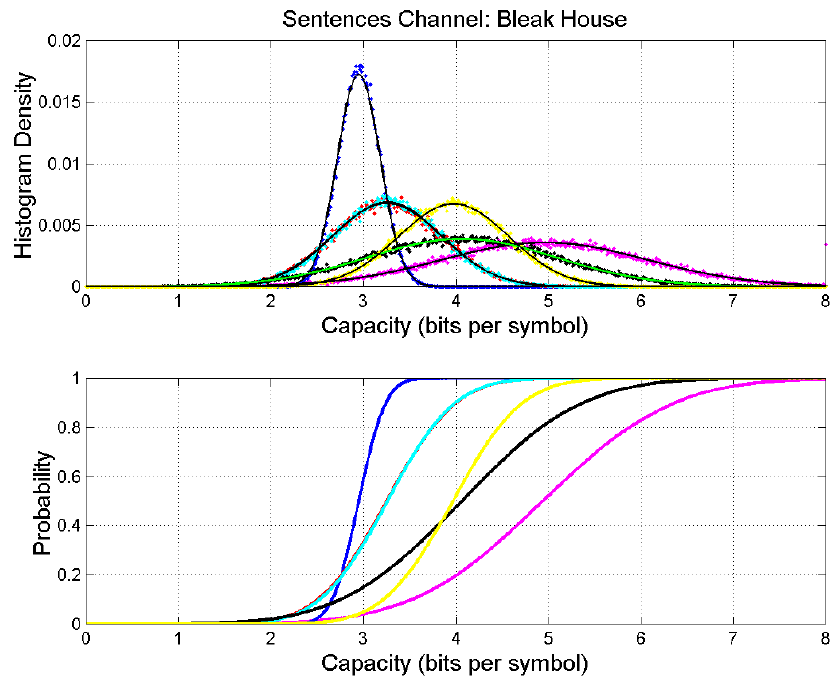
Figure 3. Upper panel : Probability density histograms of self- and cross-channel capacity. Bleak House : magenta (output); The Adventures of Oliver Twist : blue; David Copperfield : red; A Tale of Two Cities ; cyan; Our Mutual Friend : black. Matthew : yellow. The continuous black lines are the theoretical densities given by Equation (17). Lower panel : Probability distribution functions.